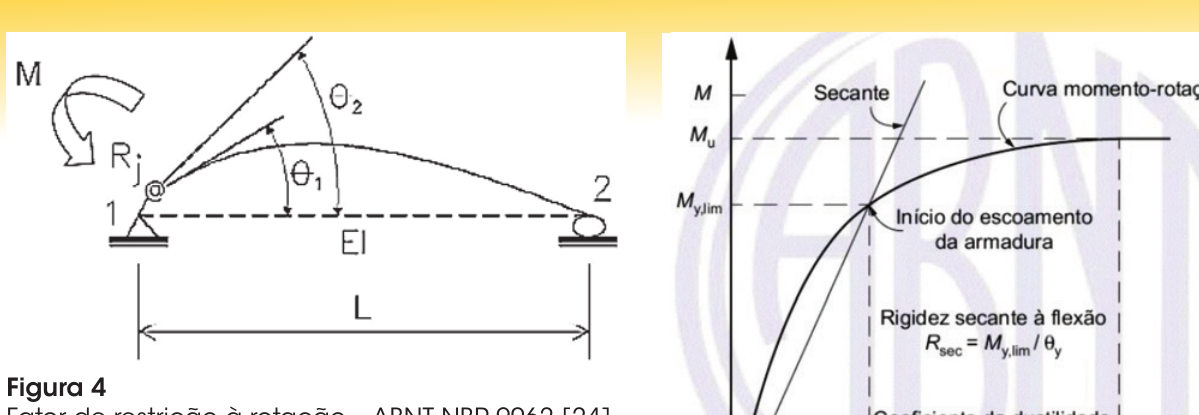
Figura 5 Relação momento-rotação na ligação viga-pilar